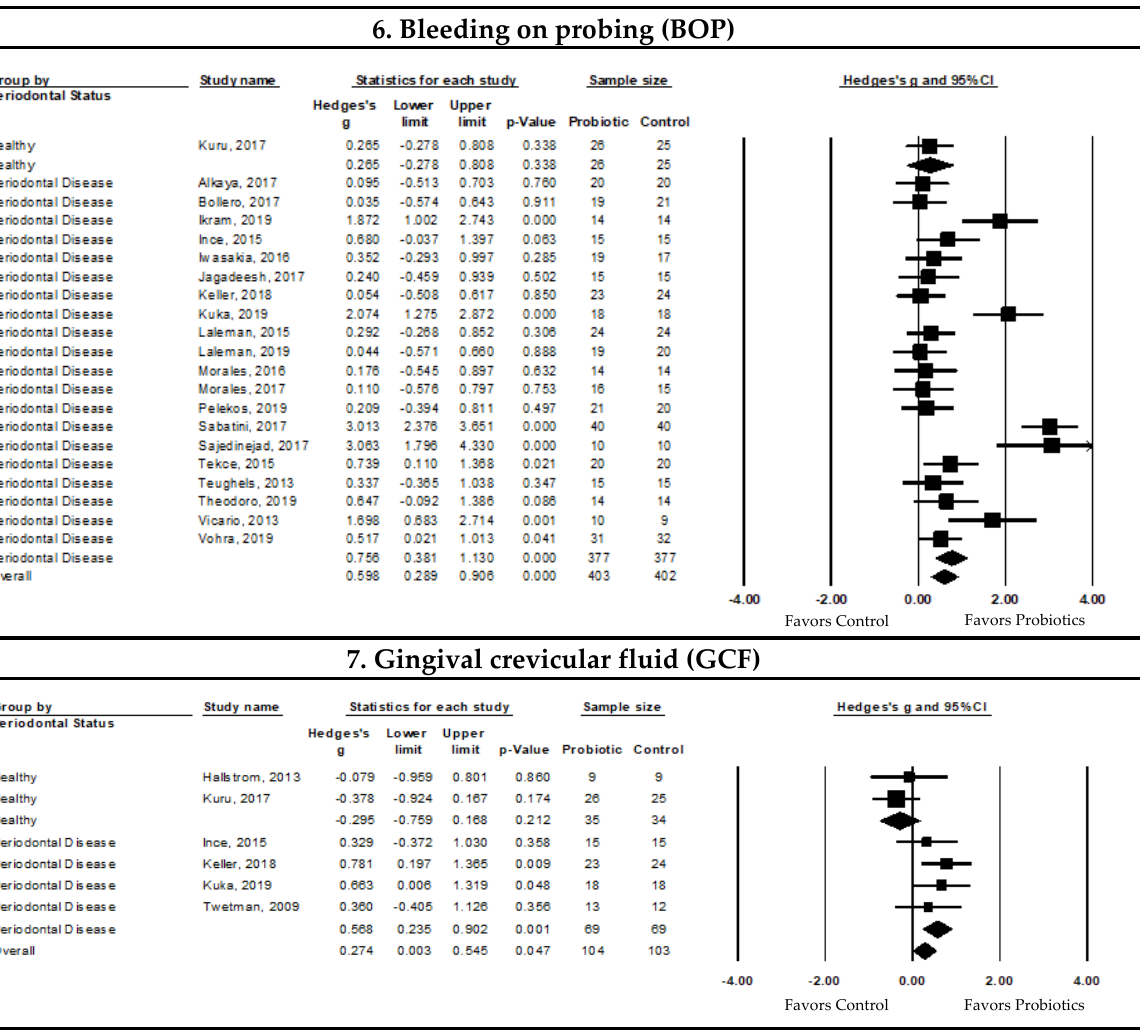
Figure 3. Pooled meta-analysis examining the effects of probiotic supplementation on clinical out- comes. 1. Forest plot of the Hedge’s g SMD comparing the effects of probiotic supplementation to control groups on the plaque index (P1I) using a random-effects model. Note that we detected publication bias and/or small study effects, and the adjusted Hedge’s g SMD = 0.557, 95% CI: 0.228, 0.885, and p -value ≤ 0.05 [14,41,43,53,58,60,62,67,69,70,80,86,91,105]. 2. Forest plot of the Hedge’s g SMD comparing the effects of probiotic supplementation to control groups on the mean plaque percentage (MPP) using a random-effects model [54,66,68,72,77,82,88,89,92,107,109]. 3. Forest plot of the Hedge’s g SMD comparing the effects of probiotic supplementation to control groups on the gingival index (GI) using a random-effects model [14,41,43,53,58,60,69,70,75,80,89,91,92,105,110]. 4. Forest plot of the Hedge’s g SMD comparing the effects of probiotic supplementation to control groups on the probing pocket depth (PPD) using a random-effects model [10,34,41,53– 55,58,60,62,64,66–69,74–77,80–82,85,89,92,102,103,109,110]. 5. Forest plot of the Hedge’s g SMD comparing the effects of probiotic supplementation to control groups on the clinical attachment level (CAL) using a random-effects model [10,34,54,58,62,66,68,76,77,80,82,85,92,102,103,109]. 6. Forest plot of the Hedge’s g SMD comparing the effects of probiotic supplementation to control groups on bleeding on probing (BOP) using a random-effects model. Note that we detected publication bias and/or small study effects, and the adjusted Hedge’s g SMD = 0.841, 95% CI: 0.479, 1.200, and p -value ≤ 0.05 [10,34,41,53,56,66,67,69,70,72,74,76,77,88,89,102,103,107,109]. 7. Forest plot of the Hedge’s g SMD comparing the effects of probiotic supplementation to control groups on the gingival crevicular fluid (GCF) using a random-effects model